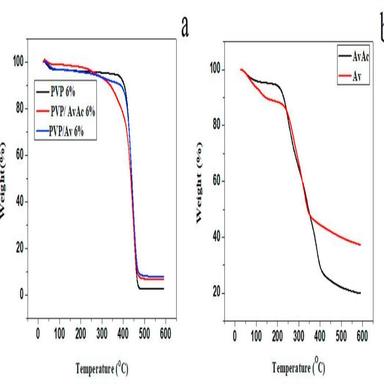
a) TGA curves nanofibers b) TGA curves of Aloe vera and Aloe vera acetate powder.